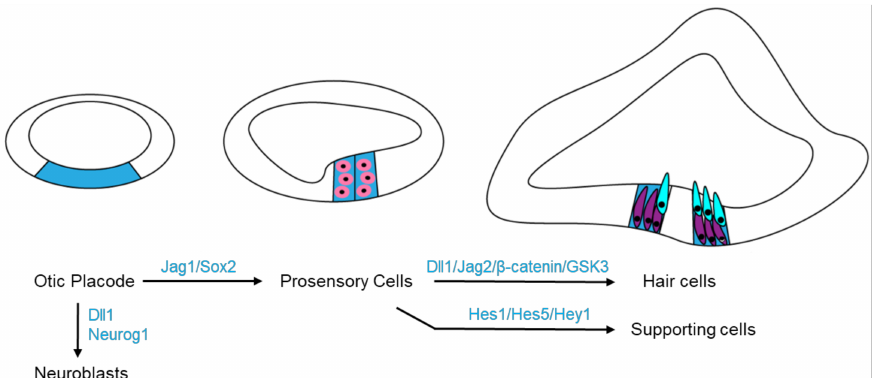
Figure 4. Molecules in the Wnt and Notch signaling pathways participate in cell fate determination during the inner ear development. Expressing Dll1 and Neurog1 on otic placode (blue) drives cell differentiating into neuroblasts, while Jag1 and Sox2 promote prosensory specification (pink). Later, Notch pathway (Dll1/Jag2) and Wnt pathway ( β -catenin/GSK3) cooperate to drive hair cell (cyan) fate; but in the surrounding cells, Notch signaling targets Hes1, Hes5 and Hey1 to direct the supporting cell (purple)